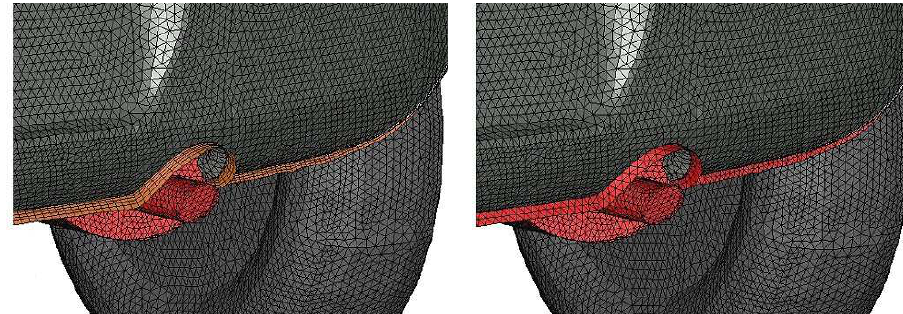
Figure 9 Handling Prism Sides using Non-conformal Interfaces